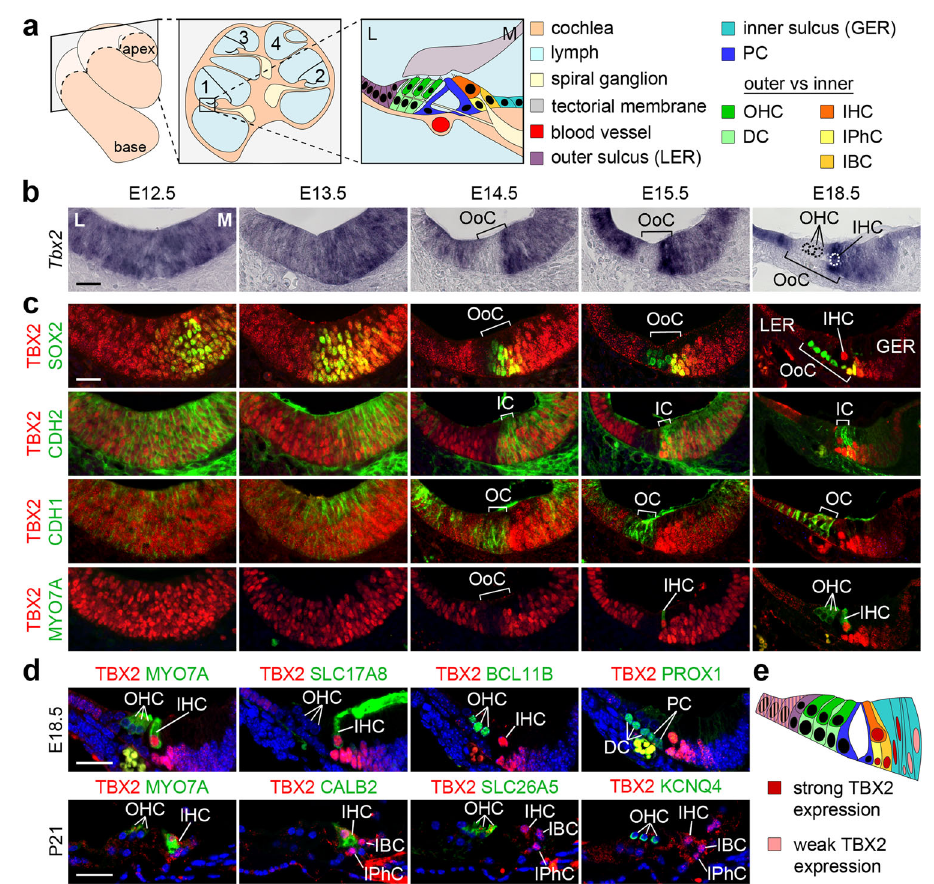
Fig.1| Tbx2 /TBX2expressionisprogressivelycon fi nedtoIHCsandISCsduring cochlear development. a Scheme showing the basal (1) and the apical (4) turn of thematurecochlea,acrosssectionthroughthecochlea,andamagni fi cationofthe basal turn with the cellular organization in and around the organ of Corti (OoC): withDeiters ’ cells(DCs)andOHCsintheoutercompartment(OC,shadesofgreen), inner phalangeal cells (IPhCs), inner border cells (IBCs) and IHCs in the inner compartment (IC, shades of yellow) separated by pillar cells (PCs) that form the tunnel of Corti. Laterally, the OoC is fl anked by cells of the outer sulcus, and mediallybycellsoftheinnersulcus. GER greaterepithelialridge(primordiumofthe innersulcus), L lateral, LER lesserepithelialridge(primordiumoftheoutersulcus), M medial. b – d Expression of Tbx2 mRNA and TBX2 protein on sections of the